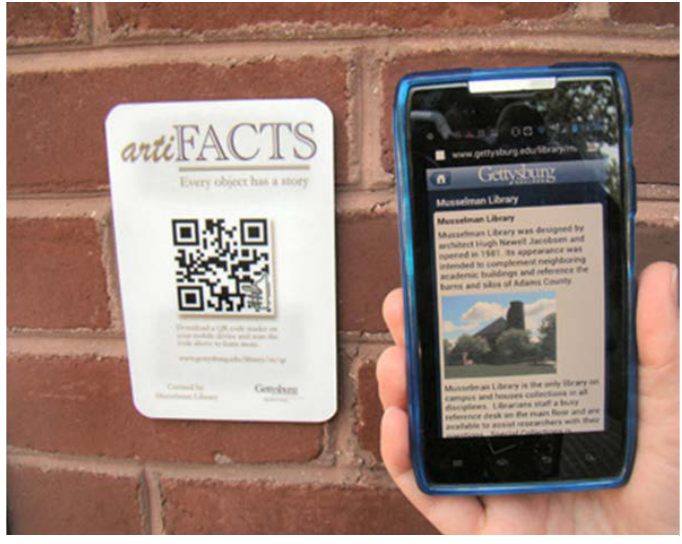
Figure 1 ArtiFACTS sign and corresponding mobile